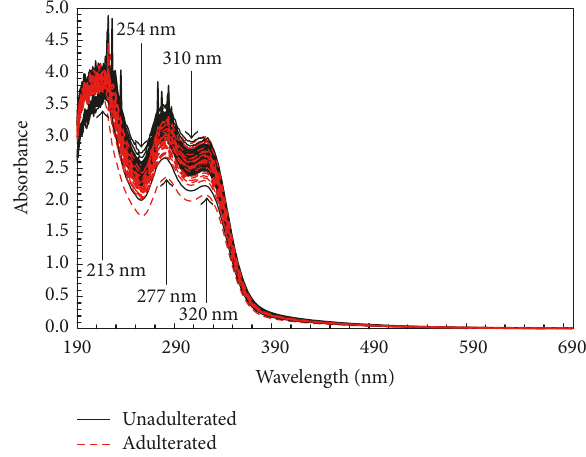
Figure 1: Original spectra of unadulterated and adulterated coffee samples in the UV-Vis